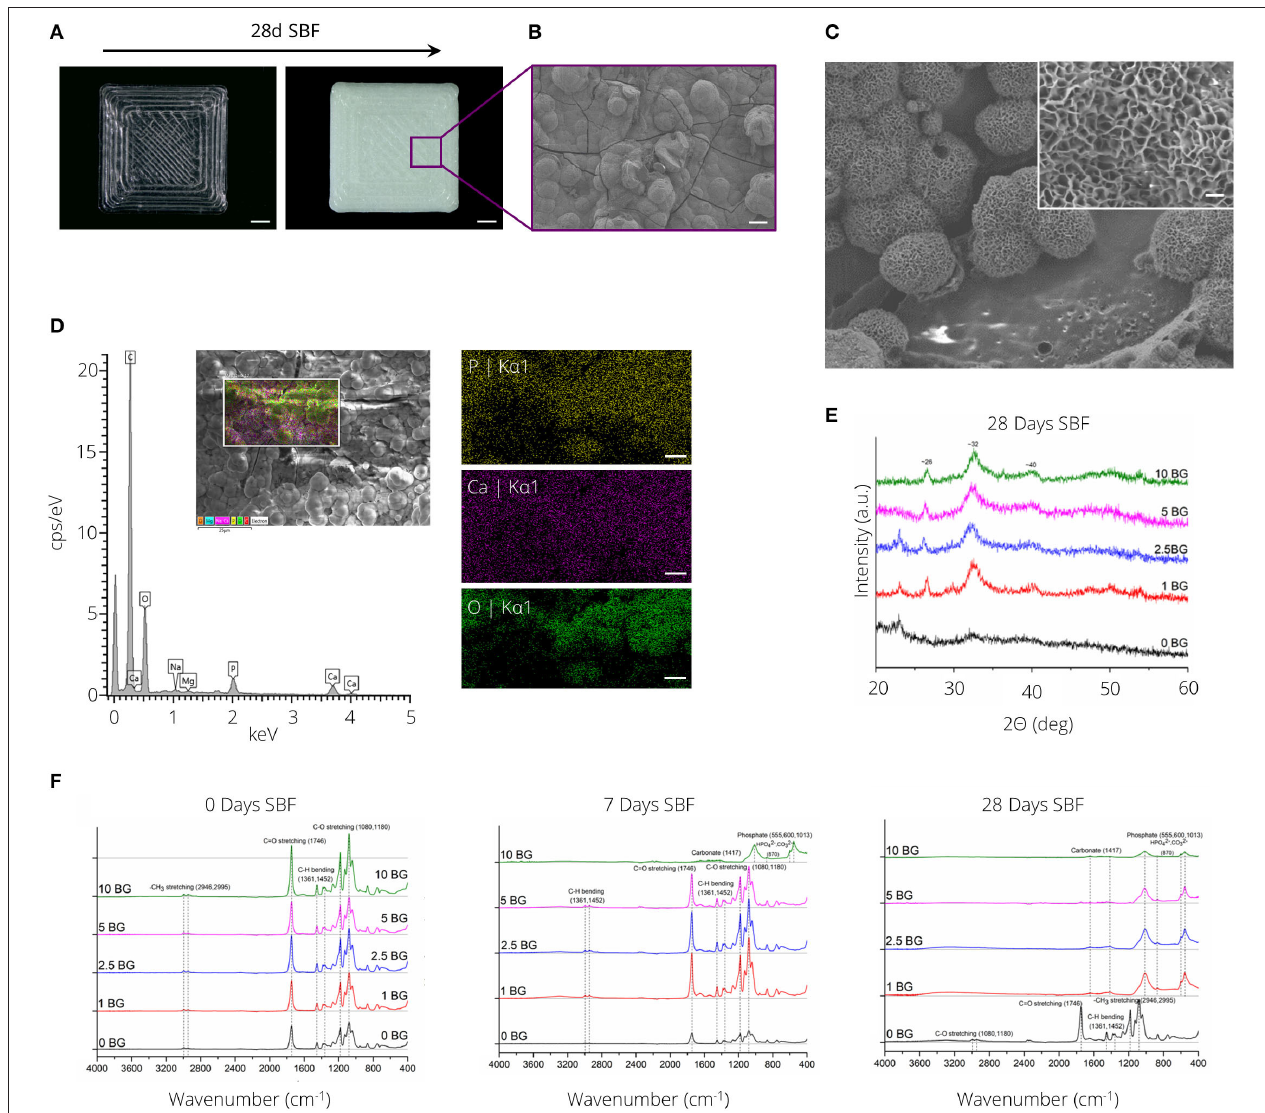
FIGURE 5 | Bioactivity assessment of PLA-BG materials. (A) Light microscopy images of 3D printed PLA-1% BG squares before (left) and after (right) incubation in simulated body fluid for 28 days. The precipitation of a white layer is apparent on the material surface. Scale bar = 2mm. (B) SEM micrograph showing the formation of a solid layer with cauliflower-like structures present, indicating the formation of a ceramic hydroxy-carbonated apatite (HCA)-like layer. Scale bar: 20 µ m. (C) SEM image of cauliflower like structure on PLA-BG after 14 days of incubation in SBF. Scale bar: 250nm. (D) Energy dispersive x-ray spectrum of PLA-10% BG scaffolds incubated for 14 days in SBF, indicating the formation of phosphorus, calcium and oxygen species on the formed layer. Scale bar: 5 µ m. (E) X-ray diffraction spectrum of the material surfaces of PLA-BG incubated for 28 days in SBF indicating the formation of crystalline species on the surface. (F) Fourier-transformed infrared spectroscopy analysis of PLA-0, 1, 2.5, 5, and 10% (wt) BG squares after 0, 7, and 28 days of incubation in SBF. The formation of new peaks indicative for carbonates and phosphates is shown over SBF incubation time.